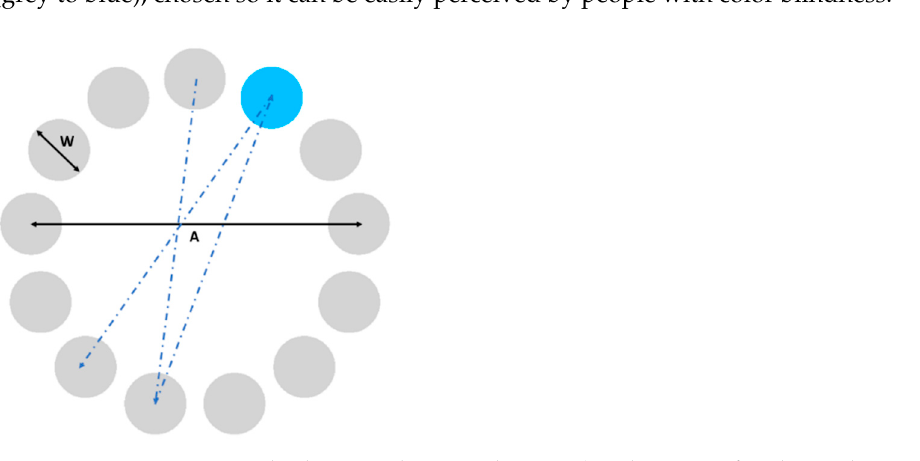
Figure 1. ISO 9241-411 multi directional point-select test ( W : diameter of each circular target, A : amplitude of each movement).